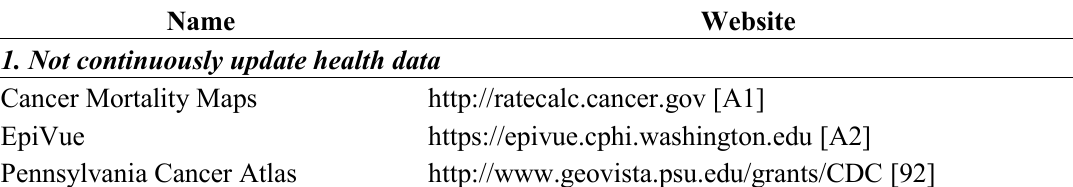
Table A1. List of excluded